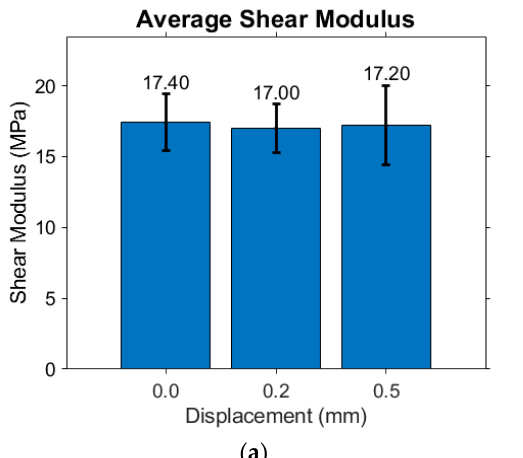
Figure 8. Specimens welded in pressure control with varying graphite coverage and resulting ( a ) average shear modulus and ( b ) shear strength.